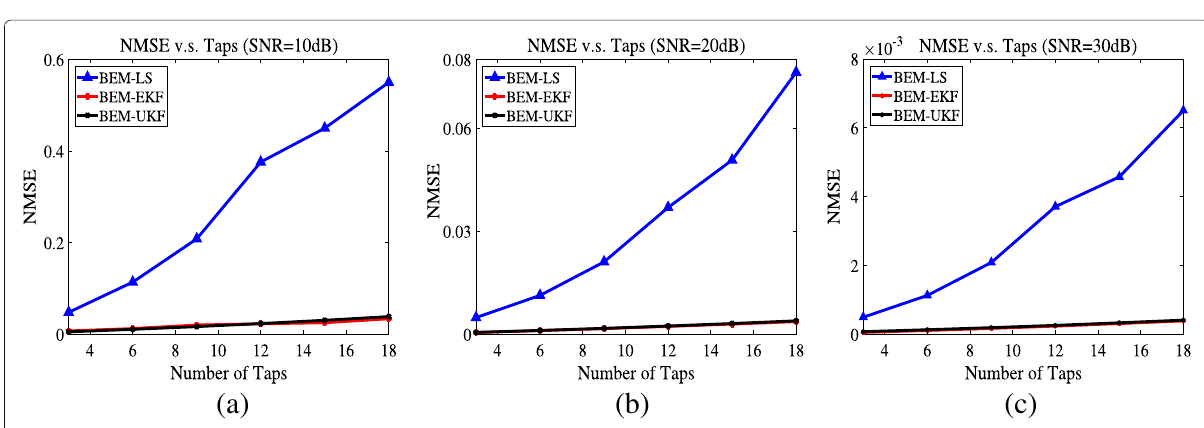
Fig. 8 NMSE for channel estimation methods in different taps and SNR environments. BEM-EKF and BEM-UKF methods can effectively overcome the influence of multi-path fading and improve the stability of CPS wireless